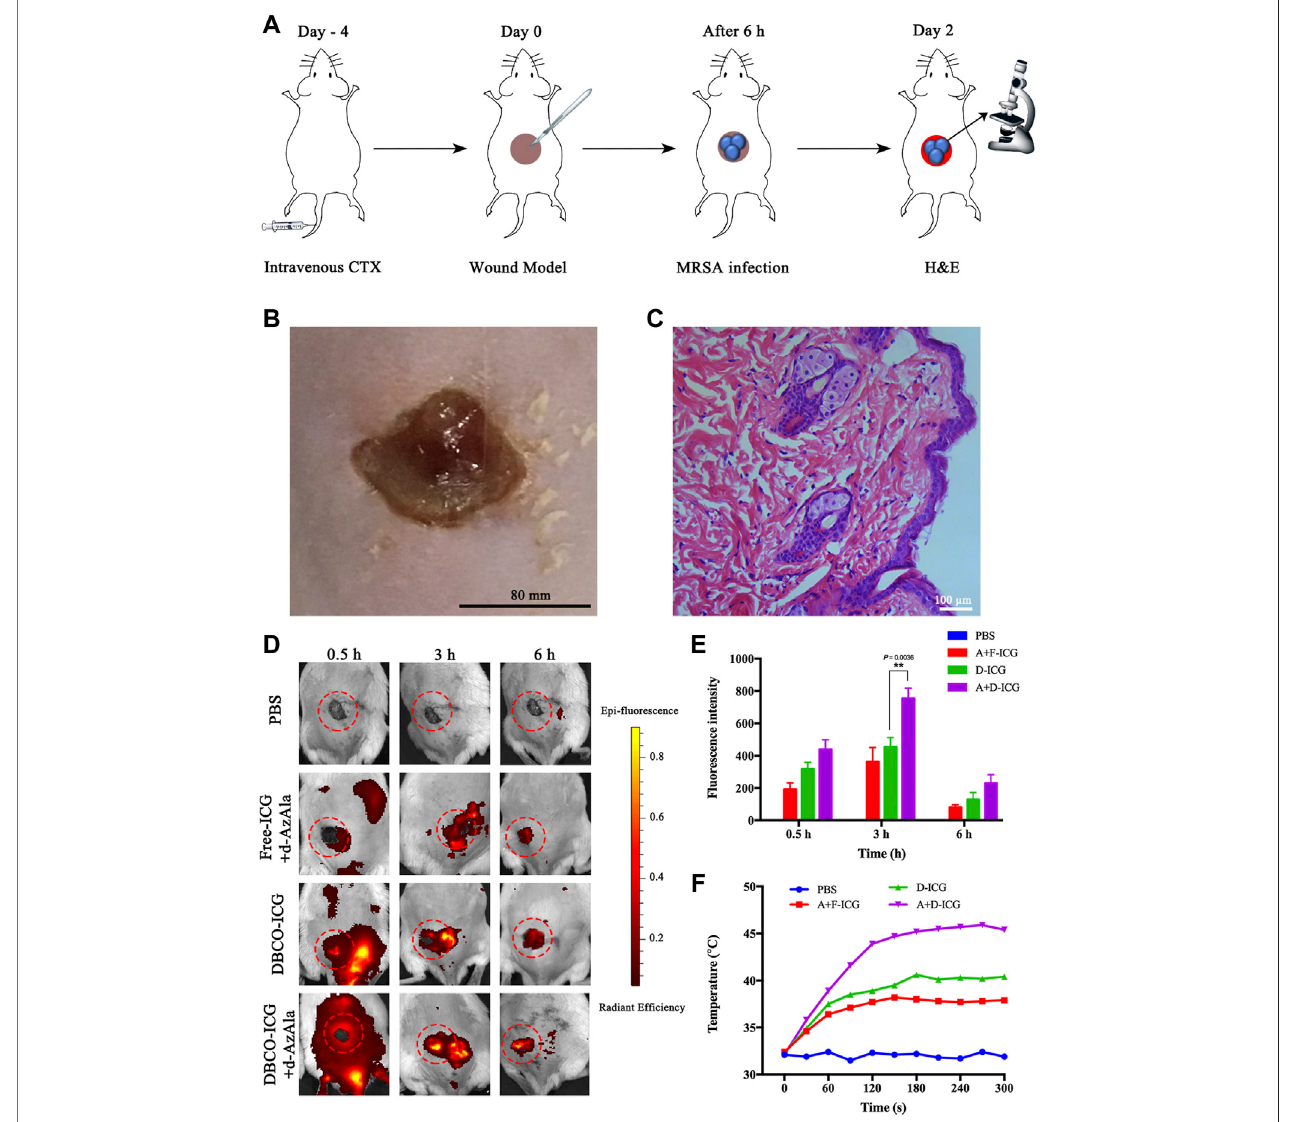
FIGURE 5 | Appraised the targeting ability of DBCO-ICG in vivo . (A) Schematic diagram of the establishment of the MRSA -infected model. (B) Skin for MRSA - infectedmodel. (C) MRSA -infectedskinforH&Estaining. (D) Invivo imagingofICGtoassaythetargetingabilityofDBCO-ICG. (E) Bioluminescencesignalquanti fi cation in MRSA -infected model (n = 5) (* p < 0.05). (F) Temperature time curve of PBS, Free-ICG + d-AzAla, DBCO-ICG, and DBCO-ICG + d-AzAla in the MRSA -infected skin region after 808 nm laser